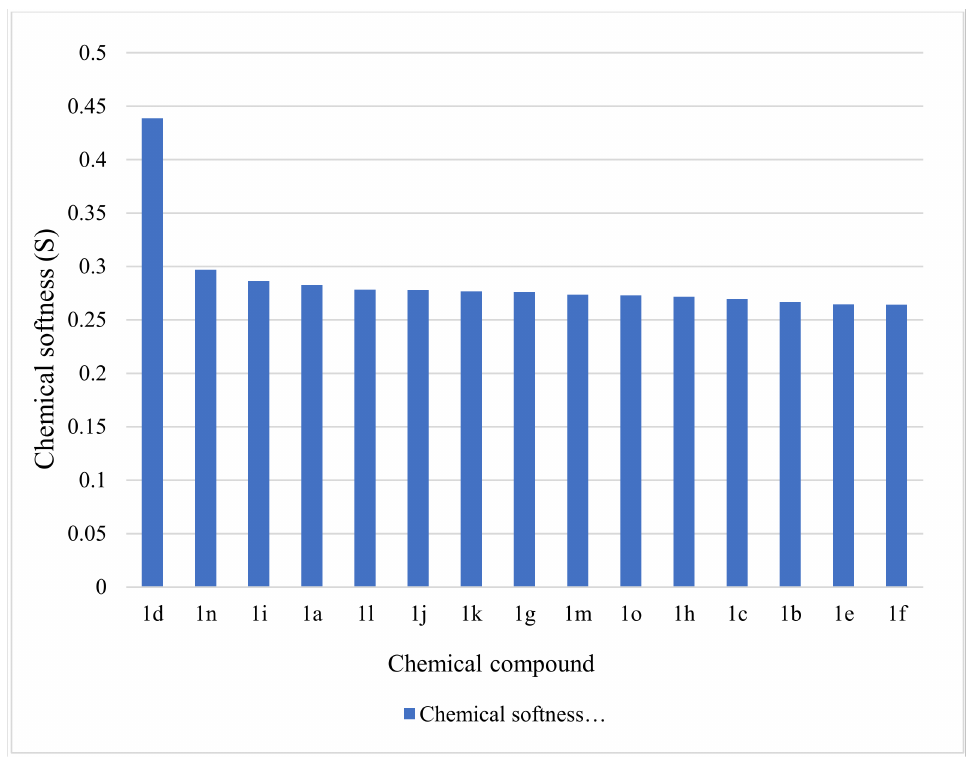
Figure 3. Graphic representation of chemical softness for the compounds 1a – 1o